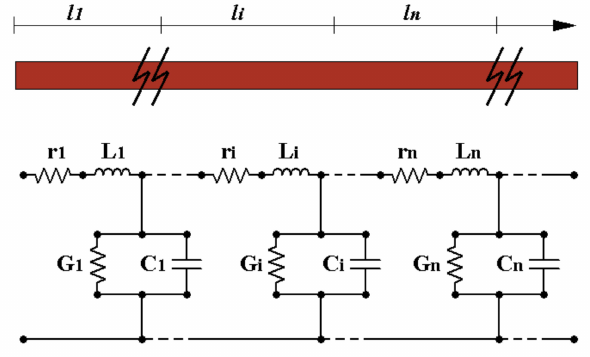
Figure 3. Representation of a grounding